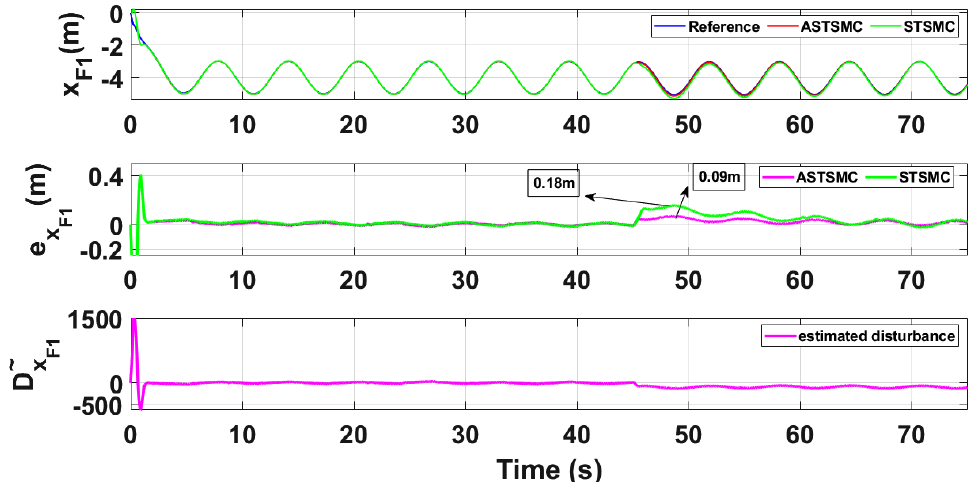
Figure 11. X F 1 tracking comparison under wind disturbance.